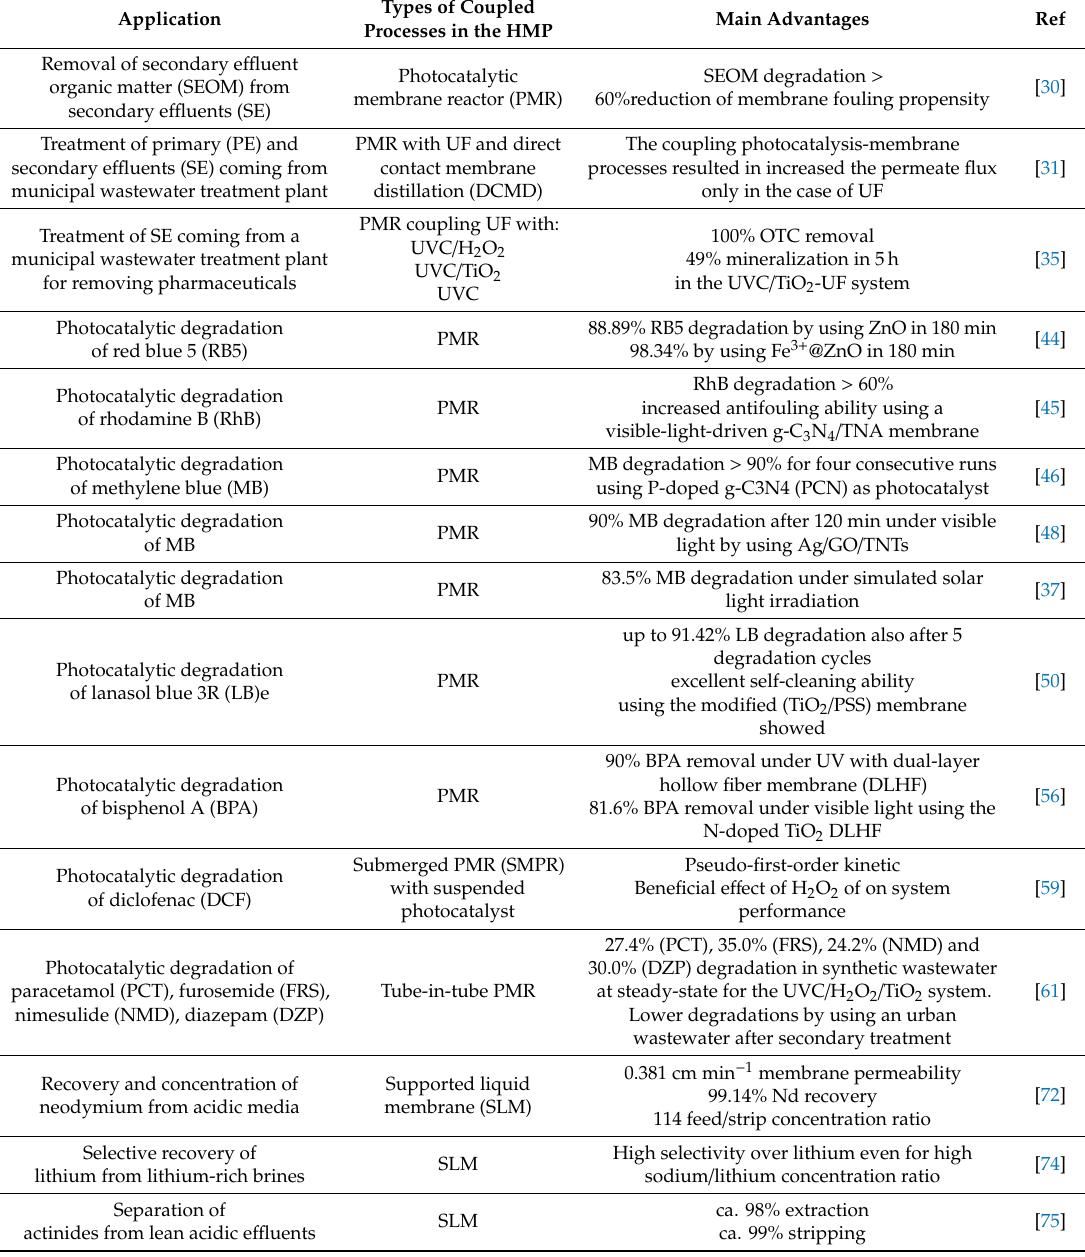
Table 1. Summary of applications, types of coupled processes in the hybrid membrane processes (HMP), and main